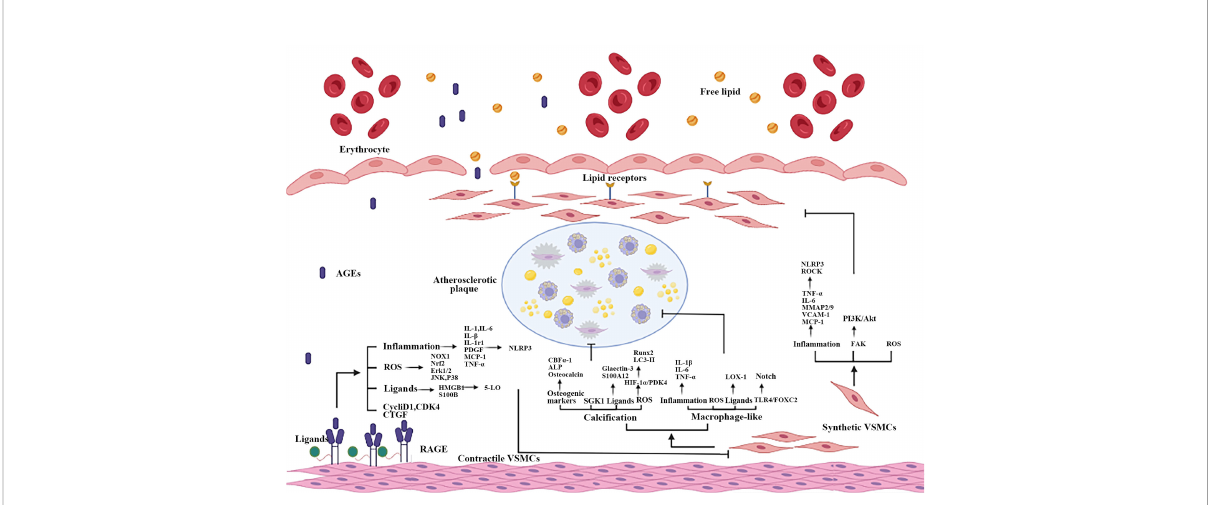
FIGURE 3 Part mechanisms of the interaction between AGEs and RAGE on atherosclerotic VSMCs. When vascular ECs are impaired, AGEs-RAGE interaction causes phenotypic transformation and VSMCs dysfunction, including proliferation, migration, calci fi cation and the increase of macrophage-like VSMCs. In fl ammation, oxidative stress, RAGE multiple ligands and other mechanisms are participated in AGEs promote atherosclerotic process by damaging VSMCs. ECs, endothelial